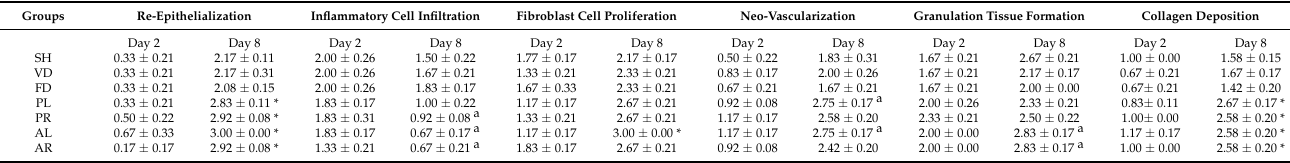
Table 4. Mean score from histological evaluation by hematoxylin and eosin (H&E) and estimation of collagen deposition by Masson–Goldner trichome (MGT) staining of seven male rat experimental groups: SH, VD, FD, PL, PR, AL, and AR. All data are given as mean ± S.E. for six animals in each group. Statistically significant results are indicated as (*) p < 0.05 versus untreated and control groups (SH, VD, and FD) and (a) p < 0.05 versus FD group. SH: sham control group (without treatment); VD: treated with vehicle (Cetomacrogol ointment); FD: treated with flavine (Acriflavine 0.1%); PL: treated with 1.0% concentration of MPvp leaves extract; PR: treated with 1.0% concentration of MPvp stem-roots extract; AL: treated with 2.0% concentration of MPva leaves extract; AR: treated with 2.0% concentration of MPva stem-roots